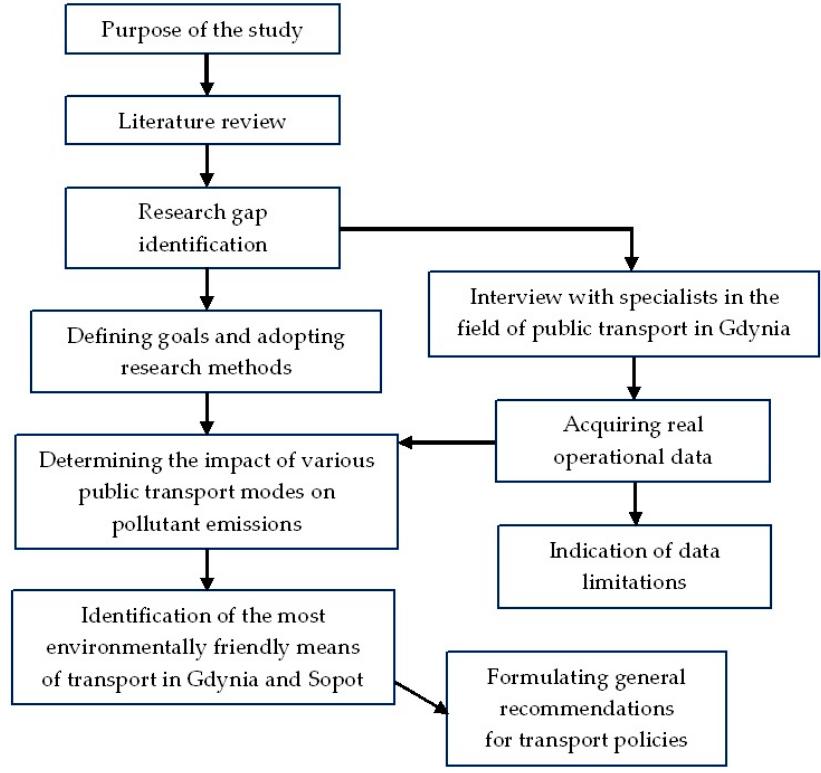
Figure 1. Scheme of the research procedure (source: Own elaboration).